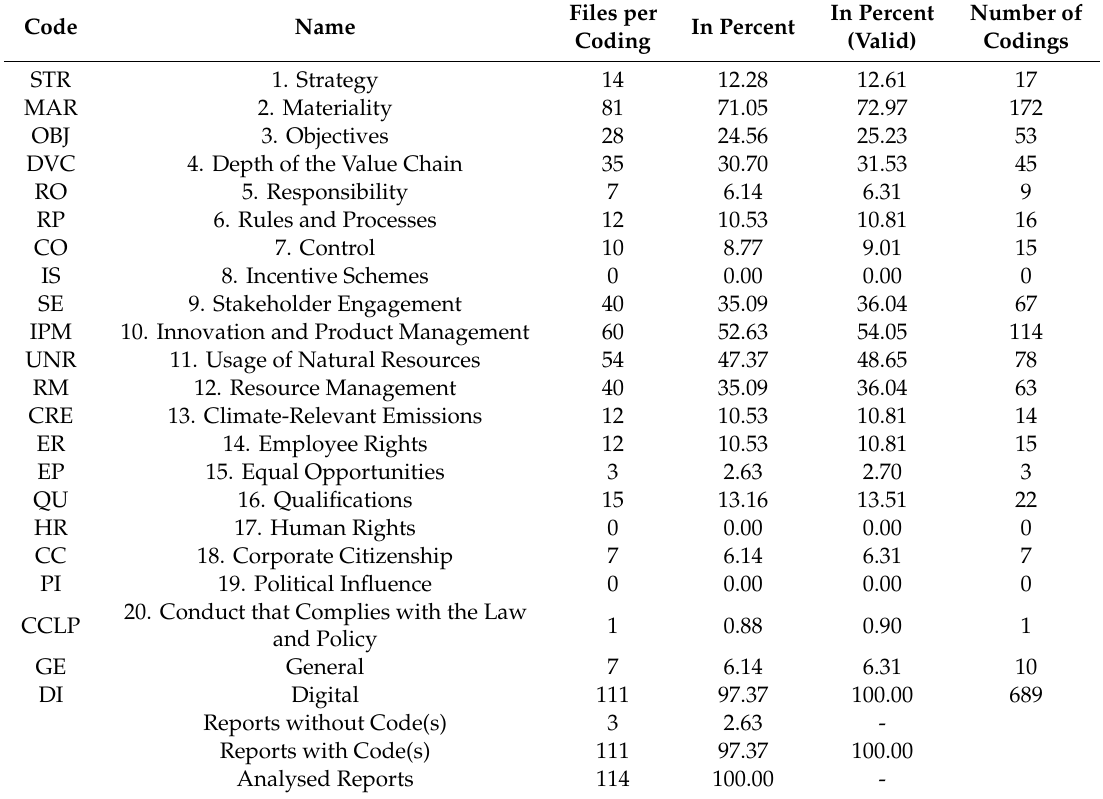
Table 2. Quantitative content